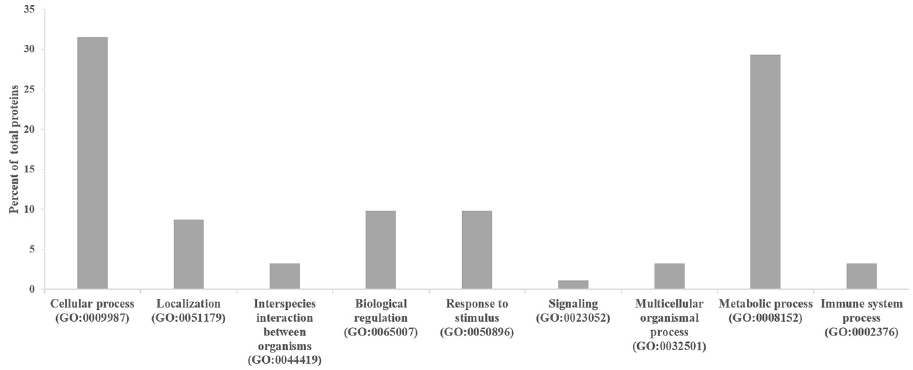
Fig 1. PANTHER database classification of the 66 proteins differentially expressed (Table 1). Proteins were classified according to their biological processes.